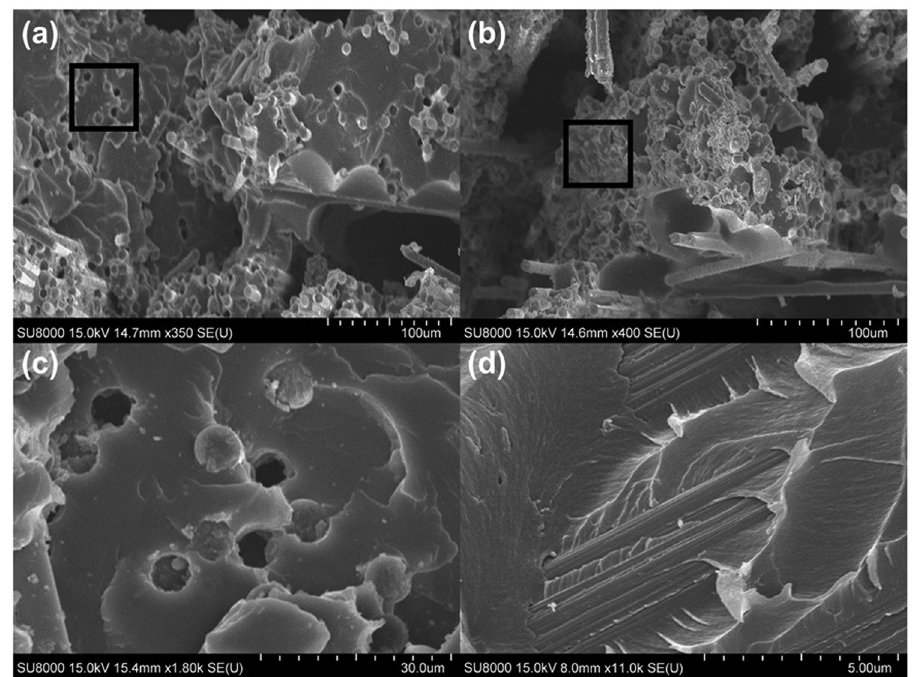
Figure 7: Fracture surfaces of BFs/epoxy and OBFs/epoxy composites: ( a ) 60 wt% BFs/epoxy composites, ( b ) 60 wt% OBFs/epoxy com - posites, ( c ) and ( d ) the magni fi ed fractured surface of the closed regions in ( a ) and ( b ) ,